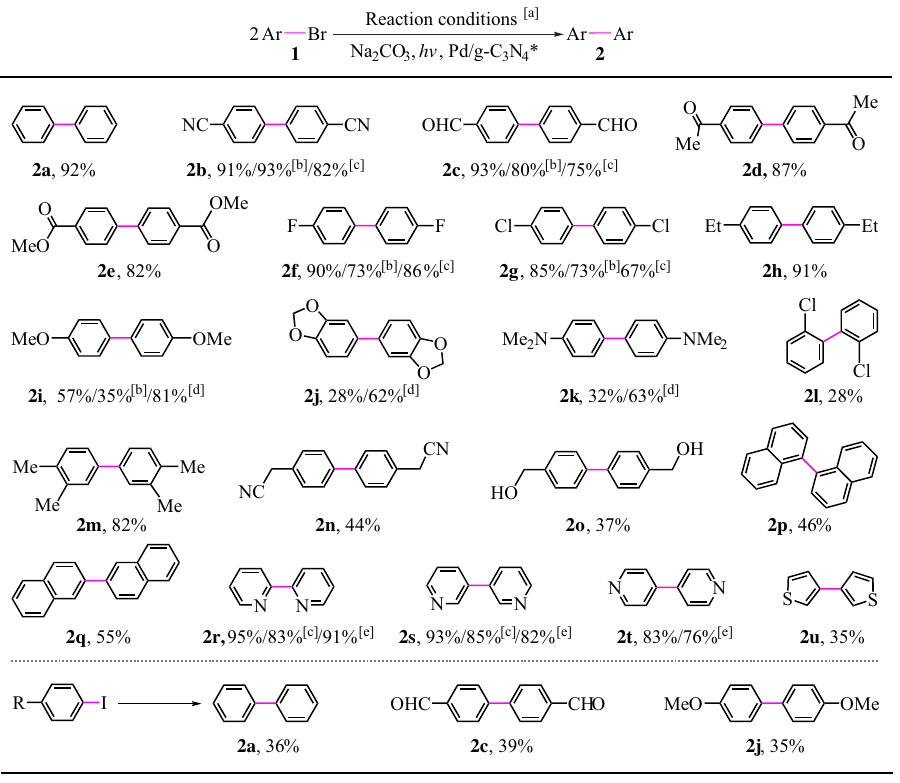
Fig. 5 | Reductive coupling of various aryl halides. a Standard conditions: 0.5mmol aryl halides, 15mgPd/g-C 3 N 4 * (2.8wt% Pd), 1.5 equiv Na 2 CO 3 , 5mL H 2 O, 3mL 1,4-dioxane, argon atmosphere, 20h, room temperature(25 o C), light source: